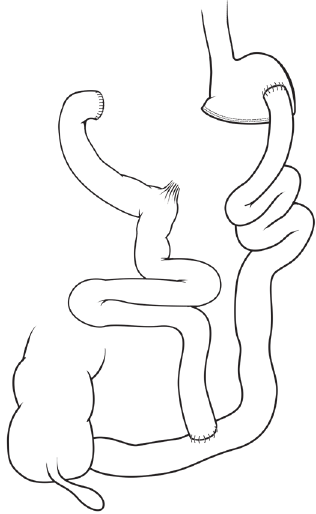
Figure 4. Biliopancreatic diversion. This is a procedure that effectively diverts bile and pancreatic secretions to the distal bowel for mixing with nutrients/chyme, typically much further distal than a Roux-en-Y gastric bypass. This procedure can be performed with or without a partial gastrectomy and is also referred to as a duodenal switch; the “switch” is the diversion of bile and pancreatic secretions from nutrient